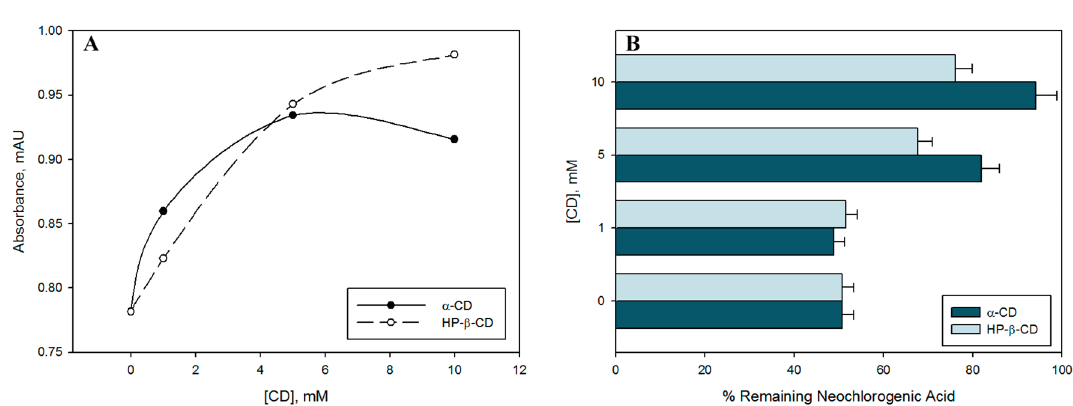
Figure 5. ( A ) Aqueous solubility and ( B ) enzymatic oxidation with polyphenol oxidase of neochlorogenic acid in the presence of α-CD and HP-β-CD (λ max = 324 nm). T-test (significance of p <